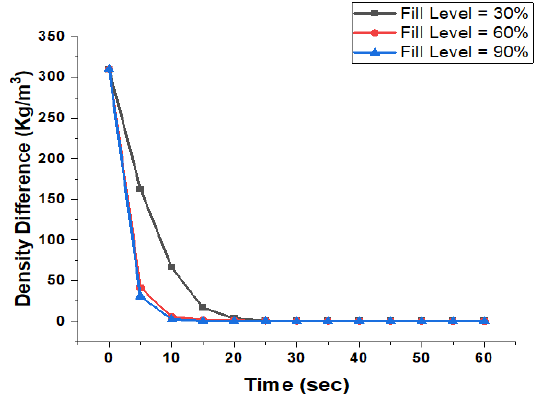
Figure 15. Plot of mixing efficiency comparison over different fill levels.